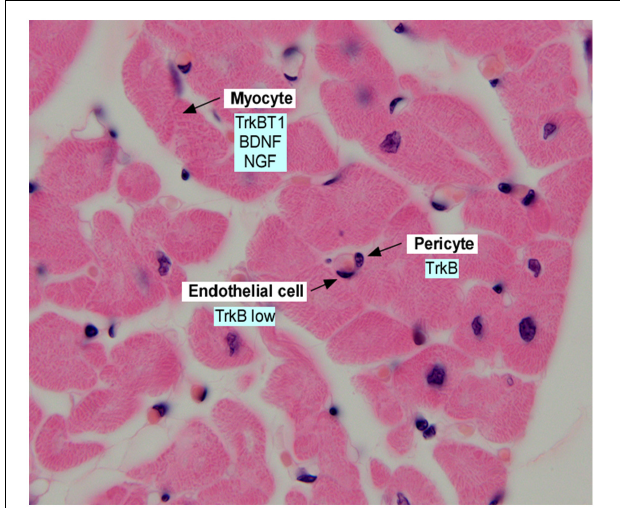
FIGURE 1 | Section of adult human myocardium, stained with hematoxylin and eosin and annotated with expression of neurotrophins and neurotrophin receptors in the indicated cell types. Data was derived from Scarisbrick et al. (1993); Yamamoto et al. (1996), Donovan et al. (2000); Wagner et al. (2005), Anastasia et al. (2014), and Fulgenzi et al.